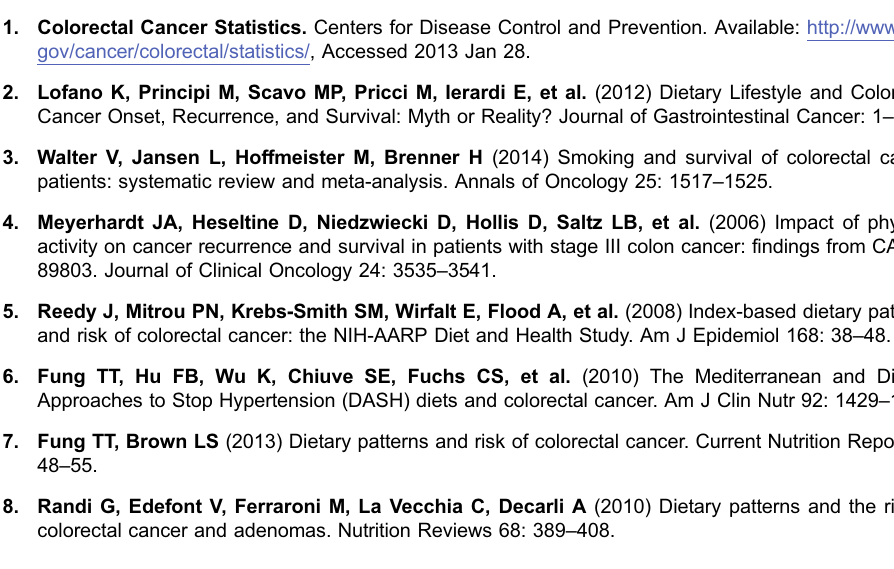
S1 Table. Hazard ratio (95% CI) for overall mortality by quintiles of post- diagnosis diet